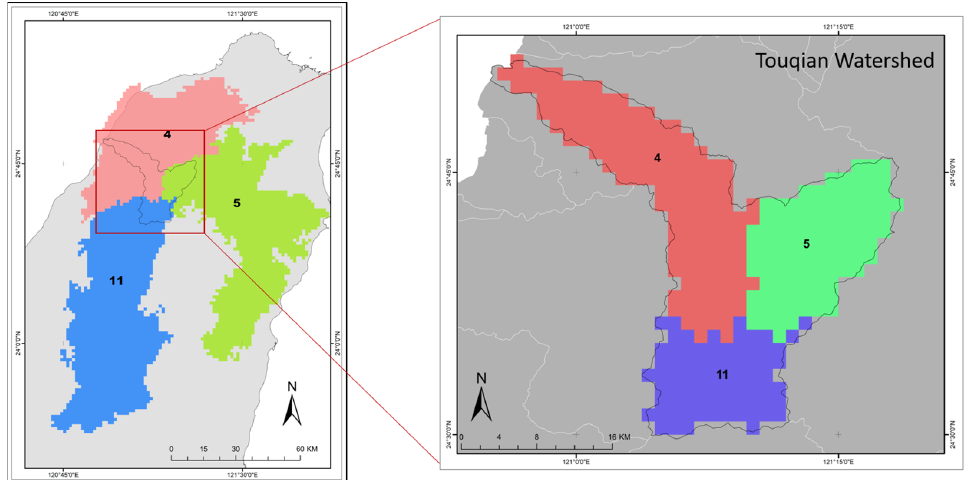
Figure 9. Touqian Watershed as region for comparing regional and grid ‐ based (at ‐ site) analysis.